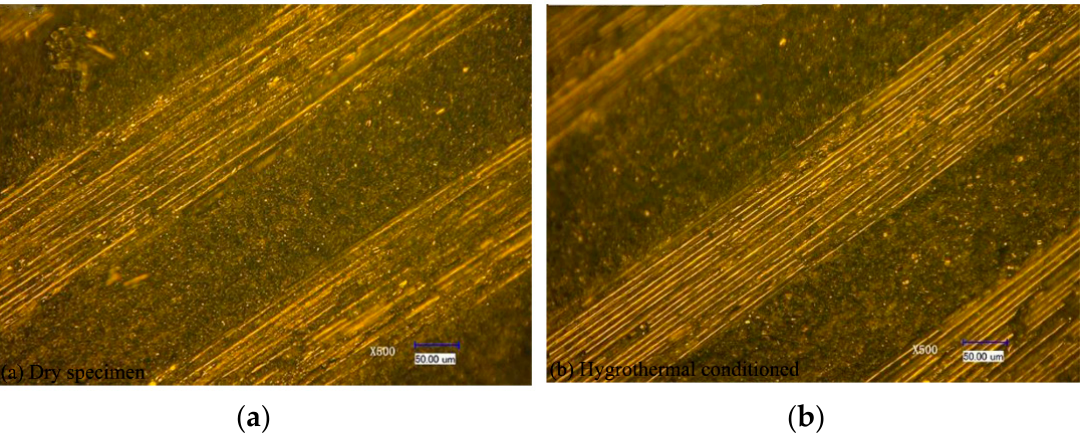
Figure 4. Images of the CFRP laminates in “dry” ( a ) and “wet” ( b ), hygrothermal (70 °C) conditions for 720 h using the three dimensional-super depth digital microscope (3D-SDDM) technique.